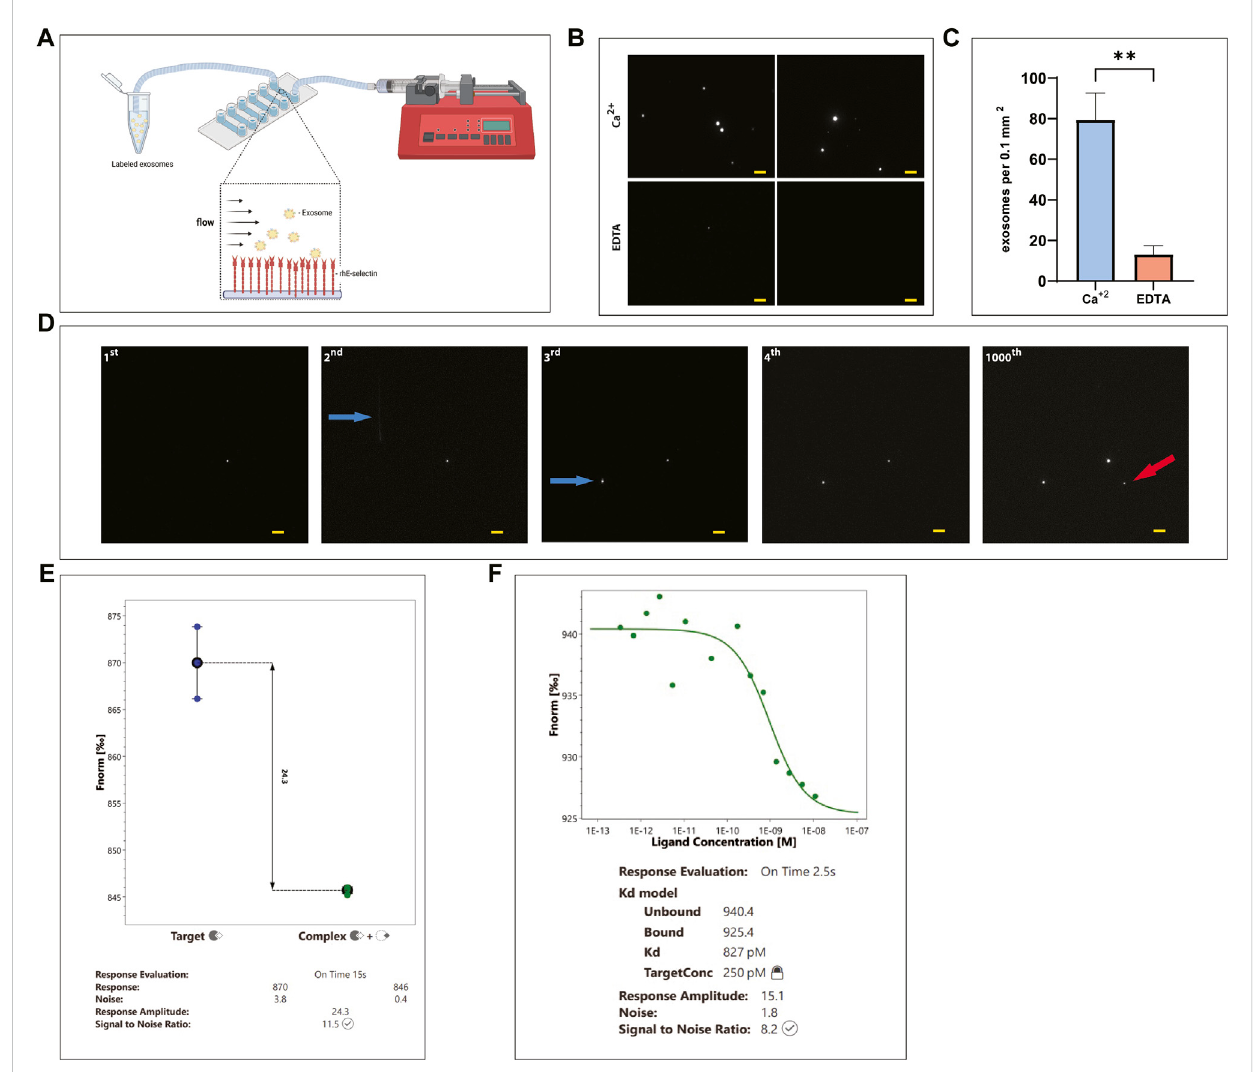
FIGURE 4 KG1a-derived exosomes bind E-selectin with high af fi nity and avidity even under fl ow. (A) Cartoon illustrating the experimental fl ow assay imaging setup showing labeled KG1a-derived exosomes fl owing over rhE-selectin, that is, pre-deposited onto a micro fl uidics chamber. Figure created with BioRender.com. (B,C) DiD labeledKG1a-derived exosomes wereintroducedintoamicro fl uidics chamber coated with rhE-selectin.Following 30 min of incubation, the chambers were washed and imaged using fl uorescence microscopy. (B) In the chambers where Ca +2 was present ( upper images), a plethora of exosomes were observed. However, in chambers where EDTA was present ( lower images), exosomes were scarce. (C) The observed differences were quanti fi ed and expressed as number of exosomes observed per area, student ’ s t-test, p -value (**) < 0.01. (D) DiD labeled KG1a-derived exosomes were introduced into micro fl uidics chambers coated with rhE-selectin at a constant fl ow of 100 μ l min − 1 and increased up to 2000 μ l min − 1 . Severalframes wererecordedtoillustrate thebindingof exosomes to thedepositedE-selectin inreal-time. Inthe1stframe, one exosome isobservedto be bound to the E-selectin. In the 2nd frame, another exosome entered the recording fi eld (white line indicated by a blue arrow) bound fi rmly to the E-selectinbythe3rdframe(indicatedbythebluearrow).ThisexosomeremainedboundstablytotheE-selectinasshowninthe4thframeandevenafter